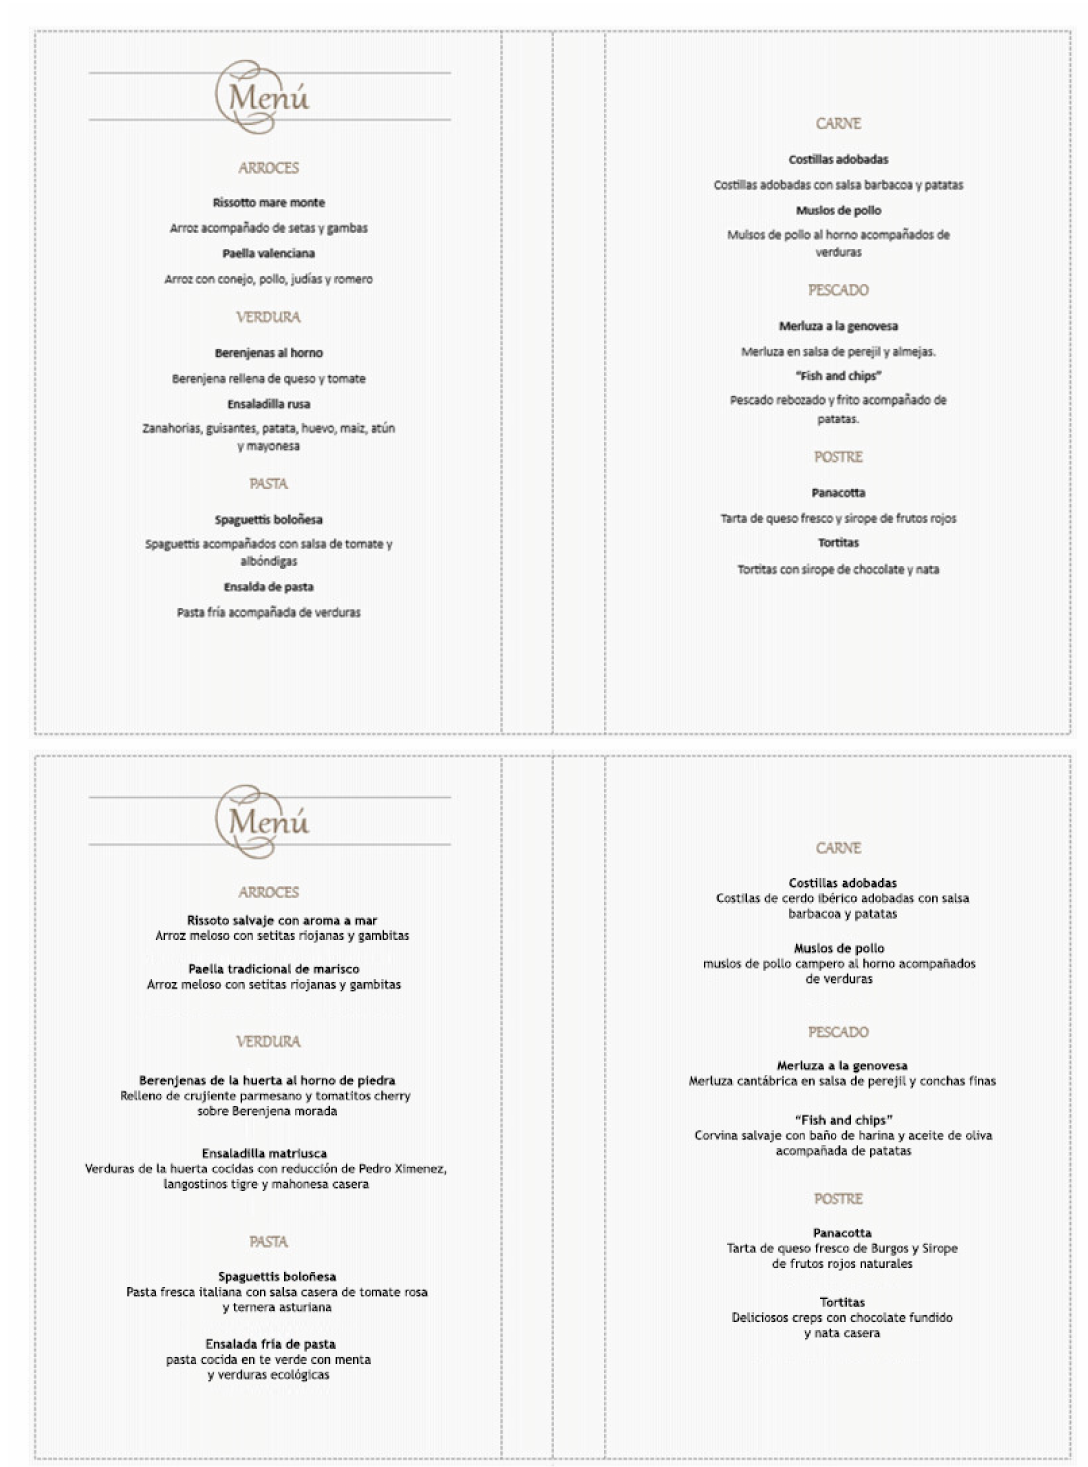
Figure 1. Dishes and menu